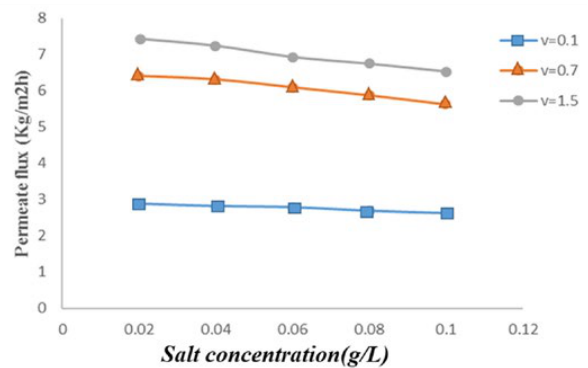
Fig. 4: The effect of salt concentration on permeate flux.